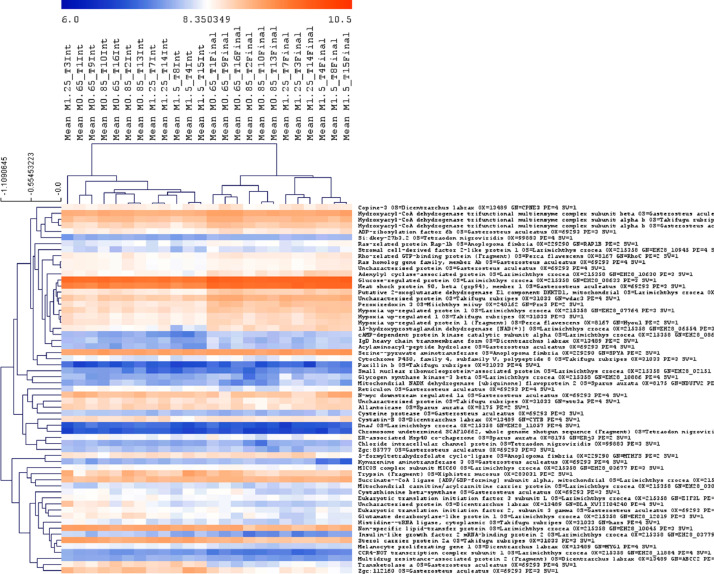
Comparison of protein pattern profiles across fish fed with diets supplemented with four different Met-concentrations at the beginning and end of the trial i.e., after 18 and 85 days. Proteins with differences in abundance (Two-way ANOVA, p < 0.05) and significant interaction between treatment and sampling time are shown. Mean values were calculated based on 3 liver samples/tank and triplicate tanks per treatment are indicated.